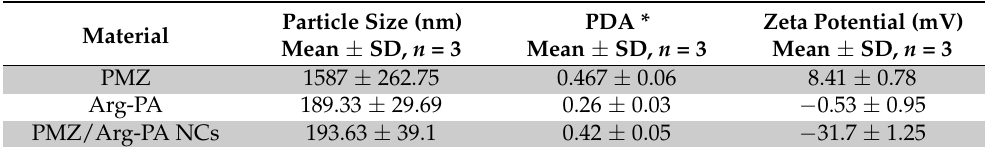
Table 4. Particle size analysis of promethazine, the polymer, and